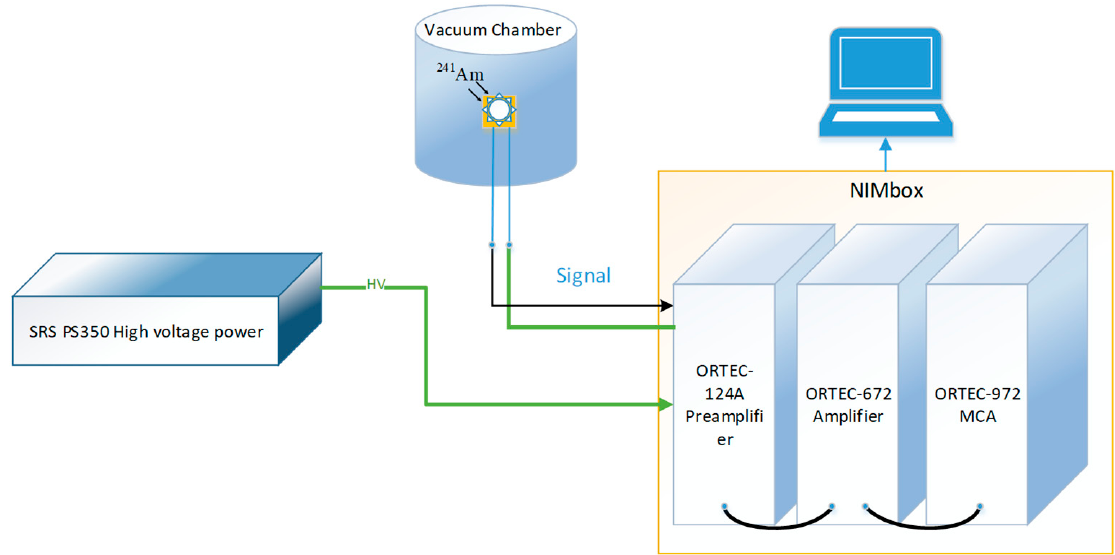
Figure 2. Schematic diagram of the γ -spectra measurement system.